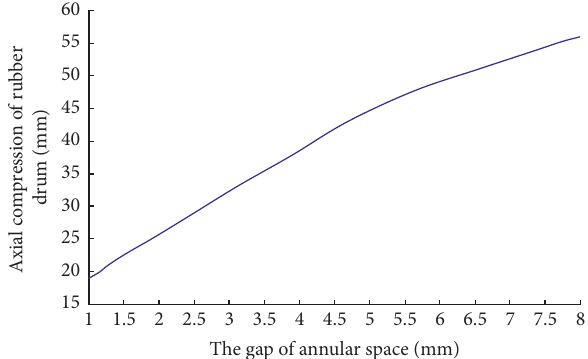
Figure 19: The maximum axial compression curve of the rubber cylinder under different gaps of